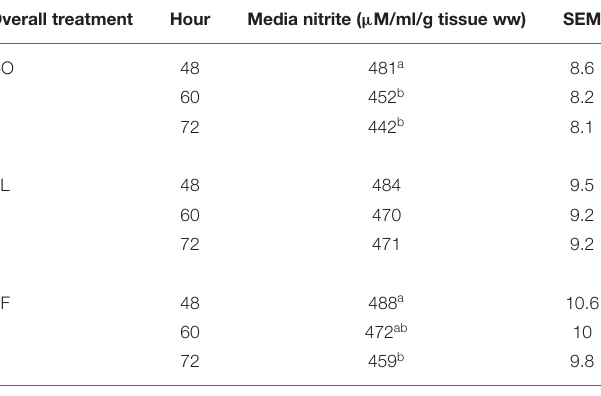
TABLE 3 | Overall media nitrite ( µ M/ml/g tissue ww) as assessed by spectrophotometric assay of the Griess reaction over time in porcine 4-mm punch biopsy antral explants cultured in sterile DMEM containing 100 U/L penicillin and 100 µ l/L streptomycin, 1 ml/L amphotericin, and 5% fetal bovine serum and refreshed